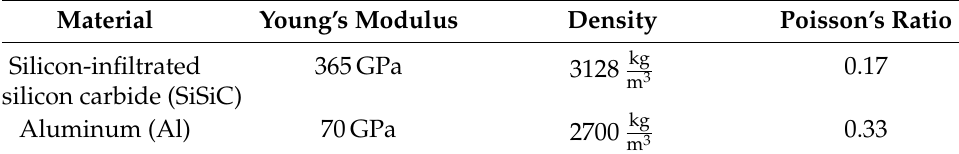
Table 1. Mechanical parameters used in the simulation studies.